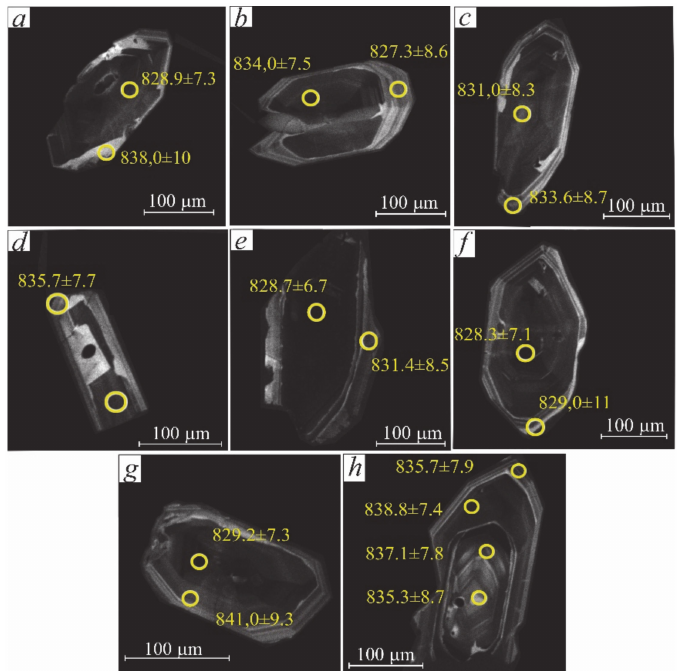
Figure 15. Representative cathodoluminescence (CL) images of zircons ( a–h ) from trachyandesite (ES-314-16) of the Ulan-Sar’dag m é lange. The yellow circles show the analyzed areas and the 206 Pb / 238 U ages